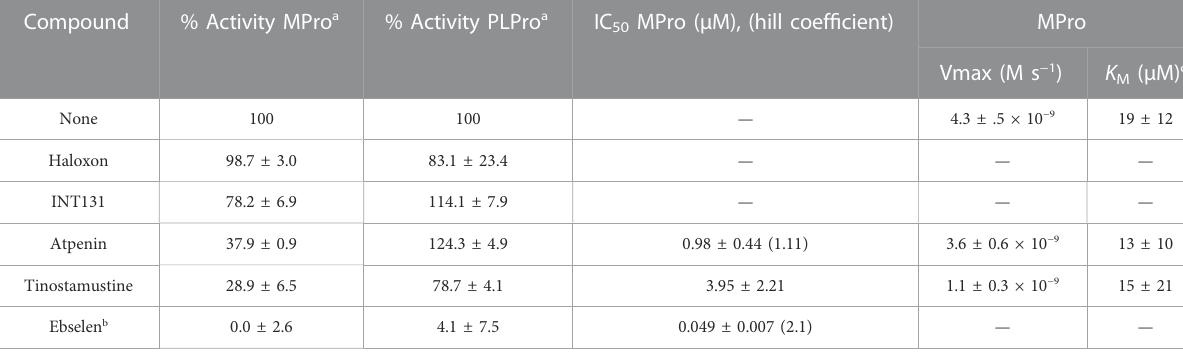
TABLE 4 Inhibition of recombinant SARS-CoV-2 proteases by MPro hit drugs identi fi ed in silico .